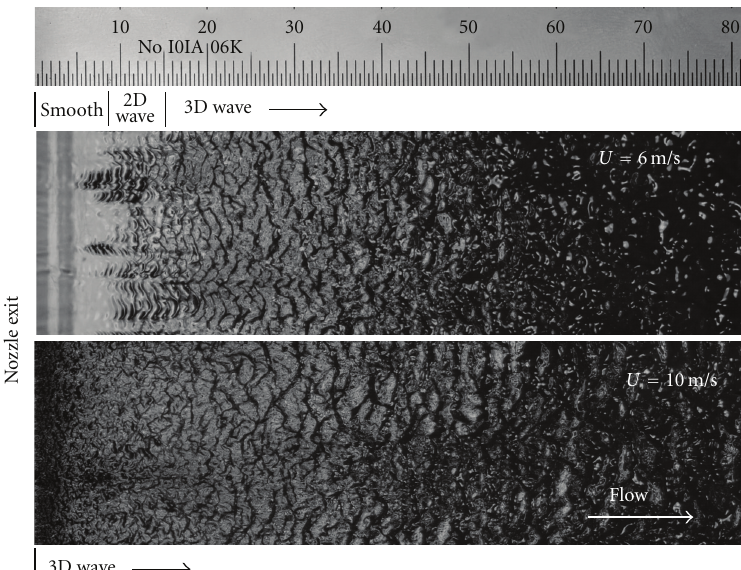
Figure 7: Structures on free surface of jet for U = 6 and